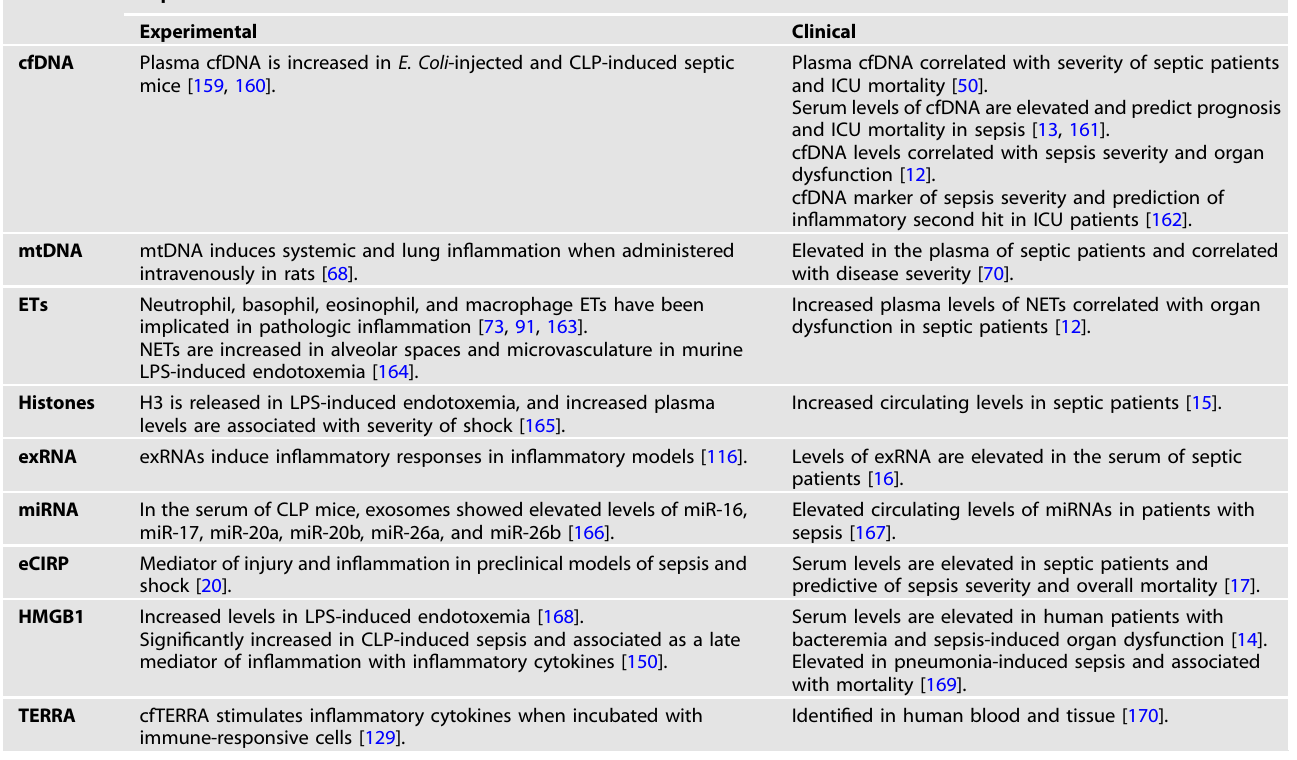
Table 1. CAMPs in Experimental and Clinical Sepsis. CAMPs Sepsis Experimental Clinical cfDNA Plasma cfDNA correlated with severity of septic patients